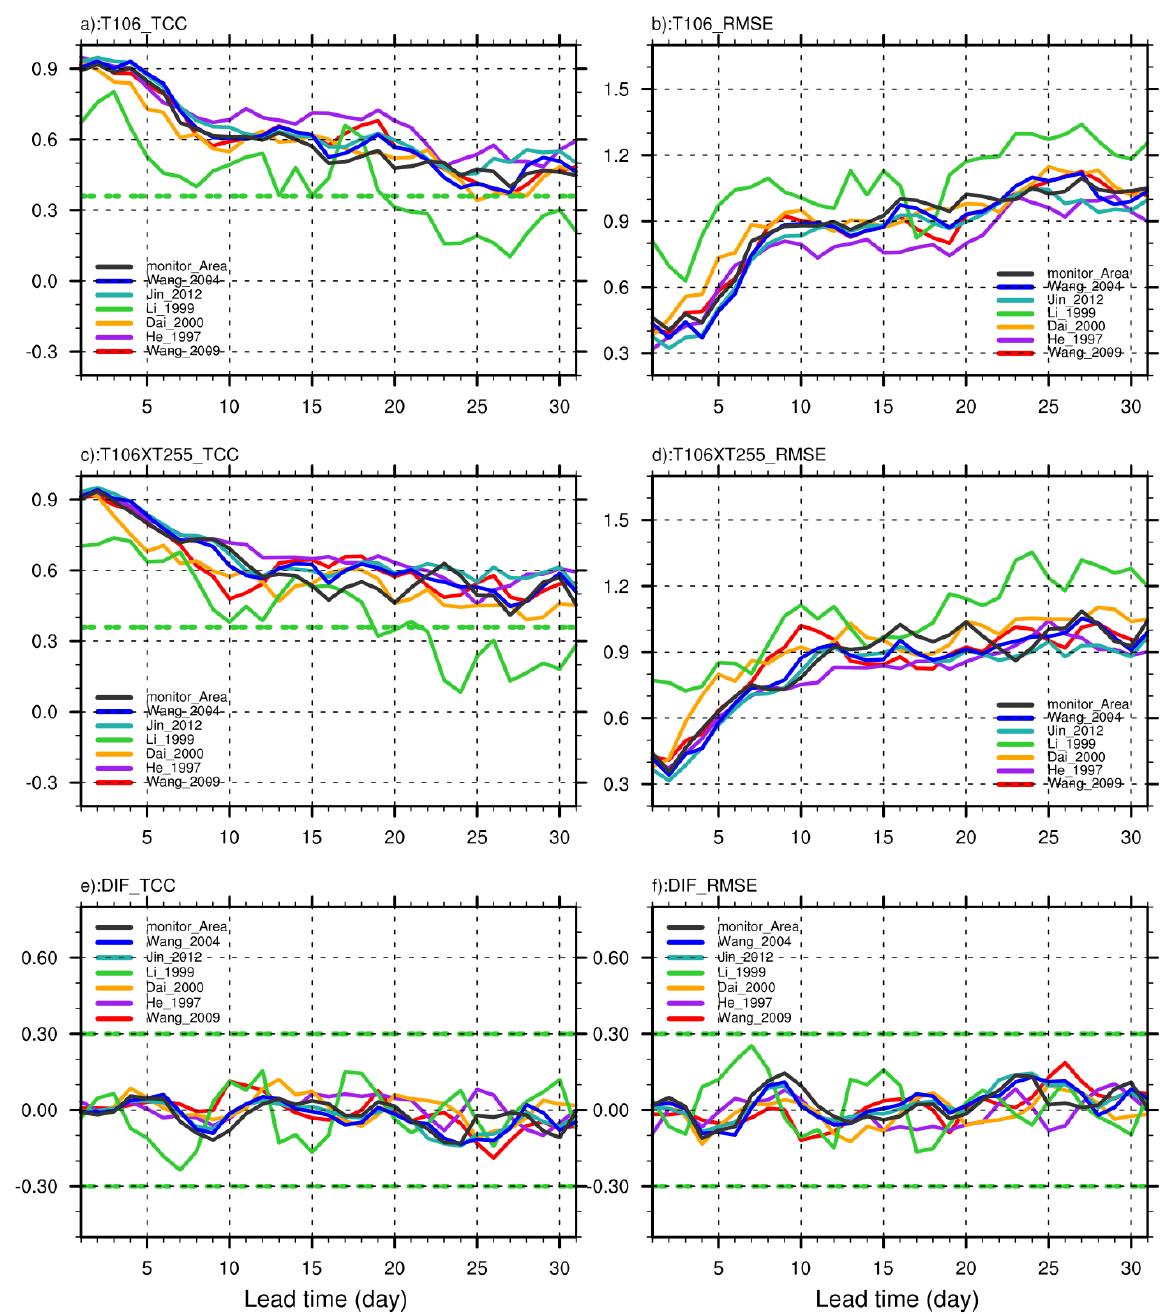
Figure 6. The TCC and RMSE between prediction and reanalysis, and the difference between two model results for lead times of 1–31 days. ( a ) TCC between T106 and NCEP2 ( b ) RMSE between T106 and NCEP2 ( c ) TCC between T106 × T255 and NCEP2 ( d ) RMSE between T106 × T255 and NCEP2 ( e ) TCC difference ( f ) RMSE difference. The green dotted line in ( a , b ) is the value (0.36) of the critical correlation coefficient passing the t -test with a confidence level of 99%.